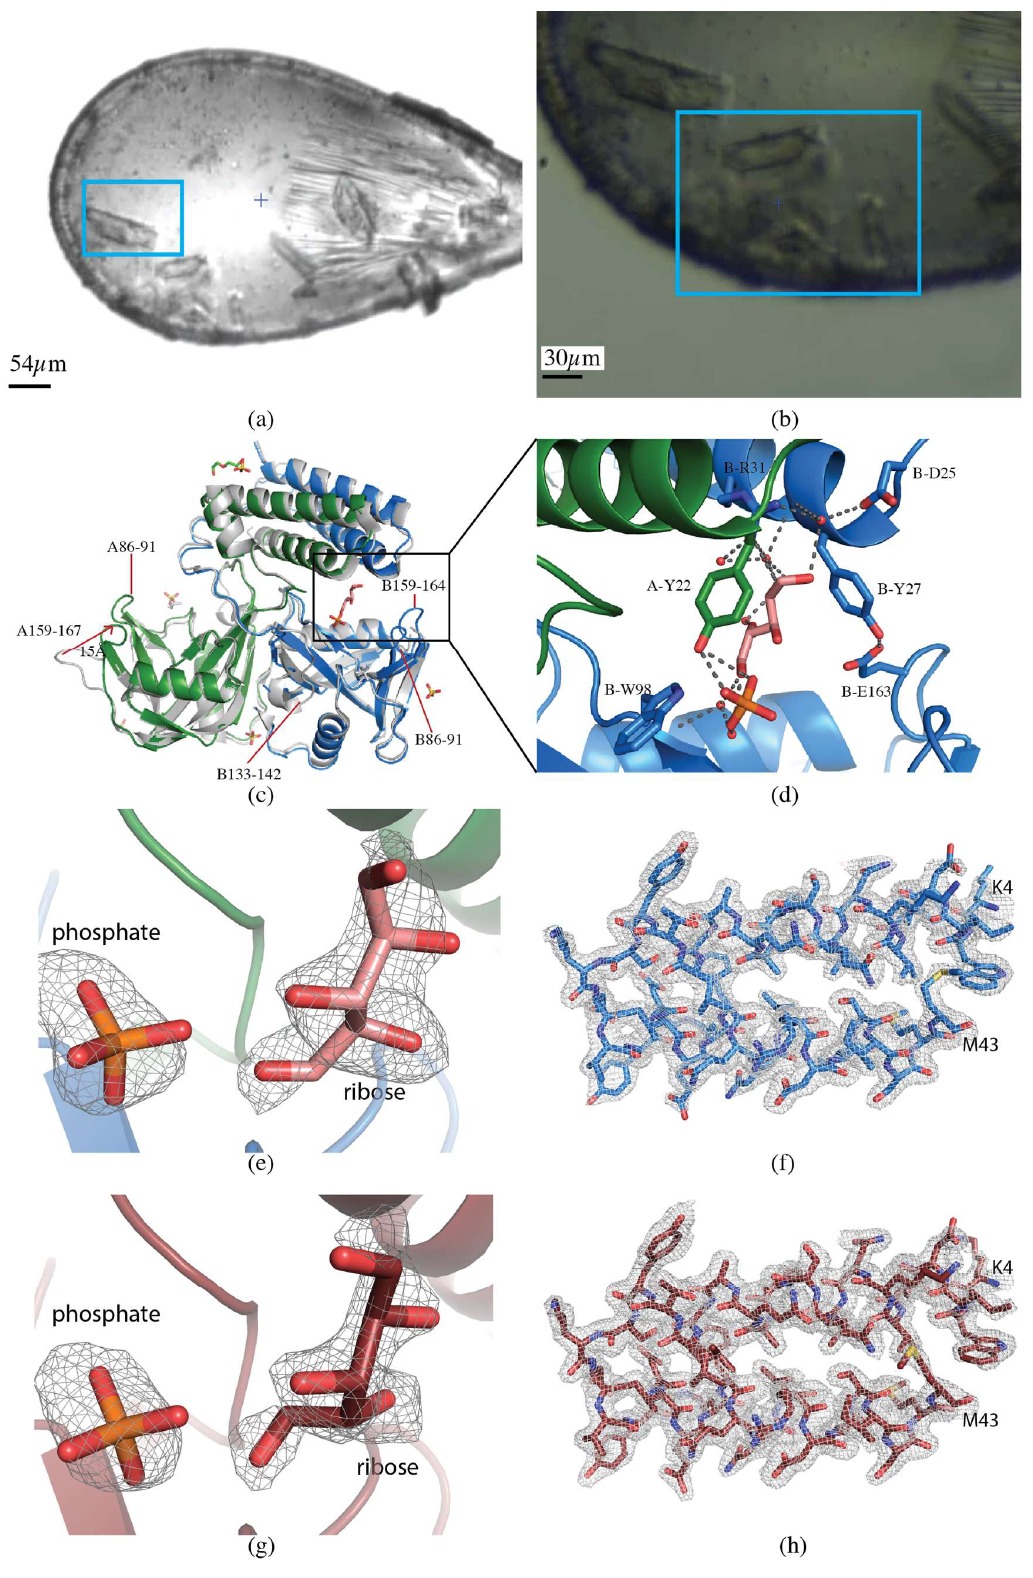
Figure 3. CDP-Chase. ( a ) Single crystal collection. Data were collected from the crystal highlighted in the blue rectangle. ( b ) Multicrystal collection. The raster data collection was performed over the region contained in the blue rectangle. ( c ) Overall structure of CDP-Chase. The alignment of the apo-